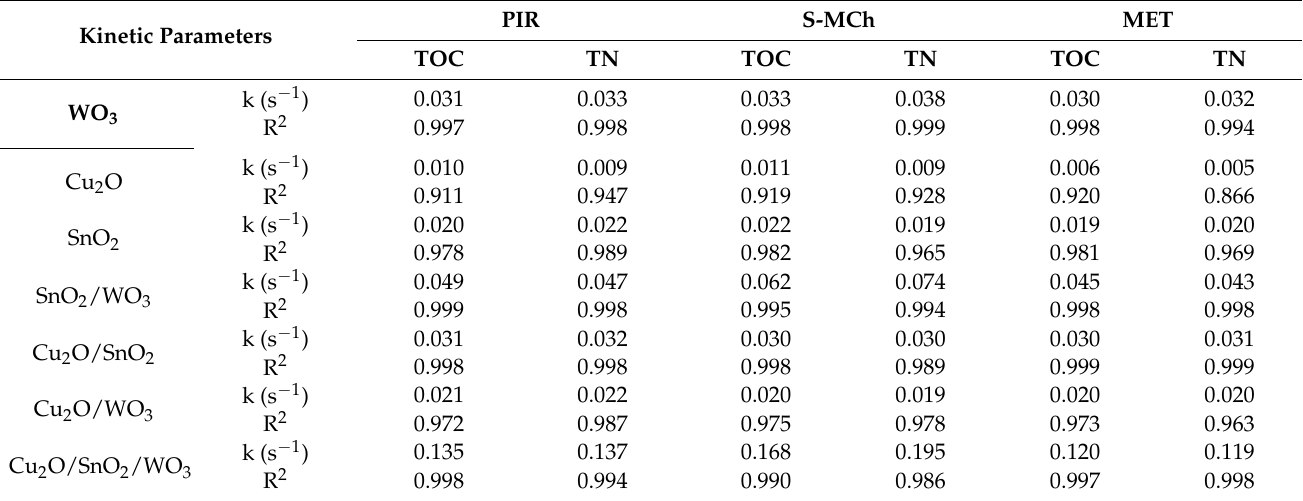
Table 3. Kinetic parameters for TOC and TN